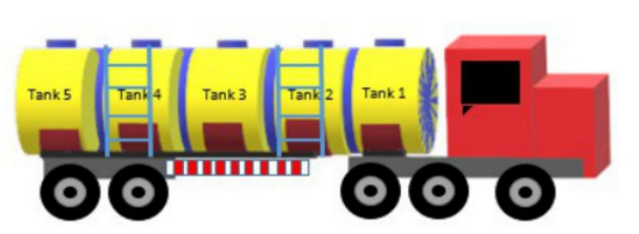
Fig.1. A vehicle with multi-compartments for fuel